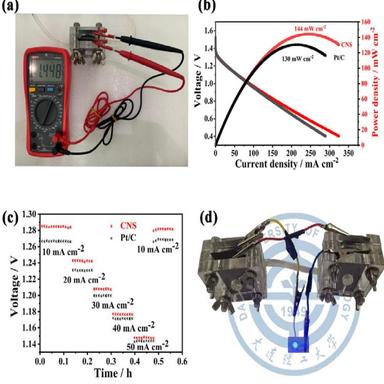
(a) The open-circuit voltage of CNS-based Zn-air battery; (b) Polarization curves and corresponding power density plots of CNS- and Pt/C-based Zn-air batteries; (c) Different rate discharge curves of the as-prepared zinc-air battery at different current densities (10e50 mA cm2 ); (d) Image of LED light by two liquid Zn-air batteries with CNS catalyst. (A colour version of this figure can be viewed online.)